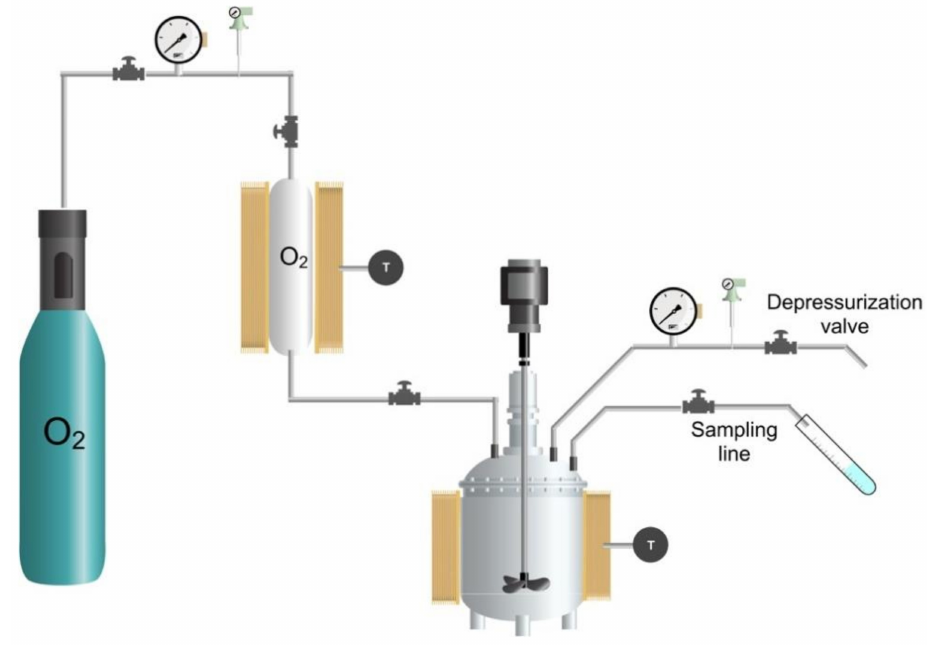
Figure 14. Experimental set-up used for catalytic